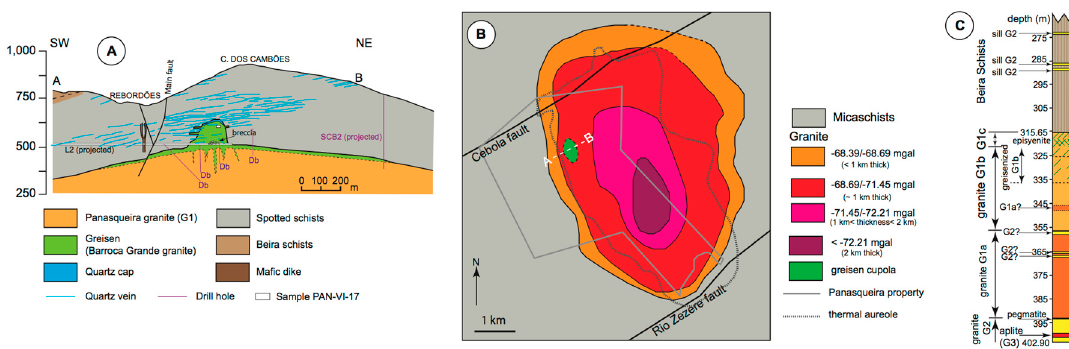
Figure 2. Panasqueira granite architecture. ( A ) The accepted petrography of the upper granite body, according to [11,12]. Section A–B is located in Figure B. Location of the old drill holes, as well as the recent SCB2 hole and new L2 gallery, are indicated. The vertical greisen roots are drawn as proposed by [12], but without any observational base (no intersection by the figured drill holes). ( B ) Gravimetric data interpretation of the shape of the granite body, according to [34]. ( C ) Synthetic petrographic profile of the SCB2 drill-hole.